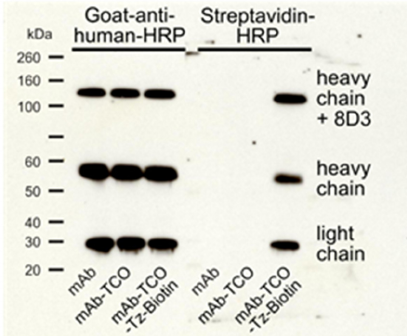
Figure 2. Western blot analysis of the mAb, mAb–TCO and mAb–TCO–Tz–biotin, generating three distinct bands, did not reveal a difference in the overall biochemical composition